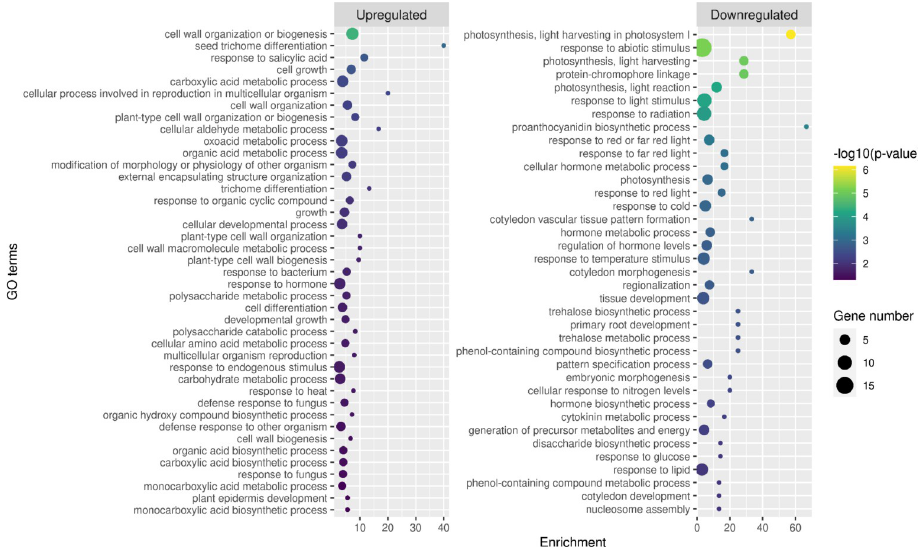
Fig 5. GO term enrichment analysis of common DEGs of TVCV and TuMV-infected Bur plants. The common DEGs of the TVCV and TuMV-infected Bur plants (orange and blue colored sets in Fig 4) were subjected to GO-term enrichment analysis using the PlantRegMap server with the default settings. Only terms in the Biological Process category are shown, the results of the full analysis can be found in S3C and S3D Table. Enrichment was calculated by dividing the observed number of genes in a particular category by the expected number of genes in that